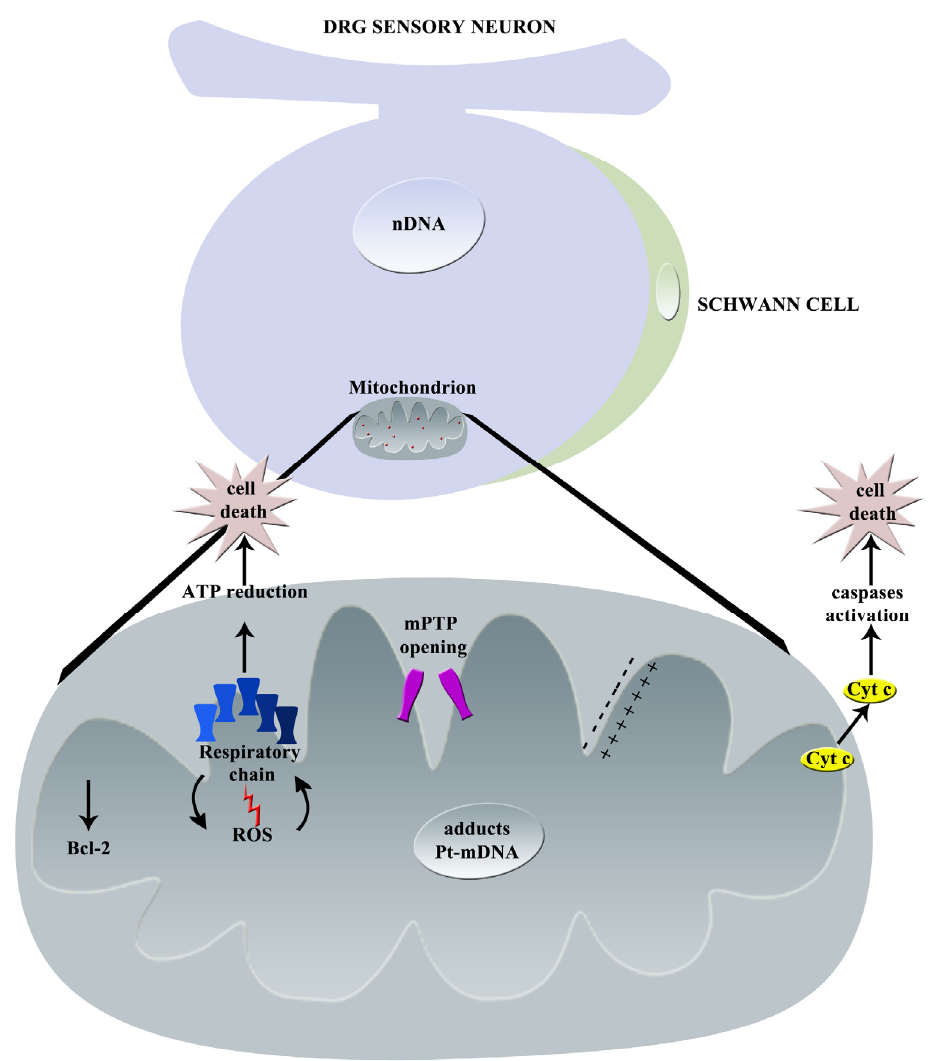
Figure 3. Graphical summary of oxaliplatin-induced mechanisms of neurotoxicity: principal